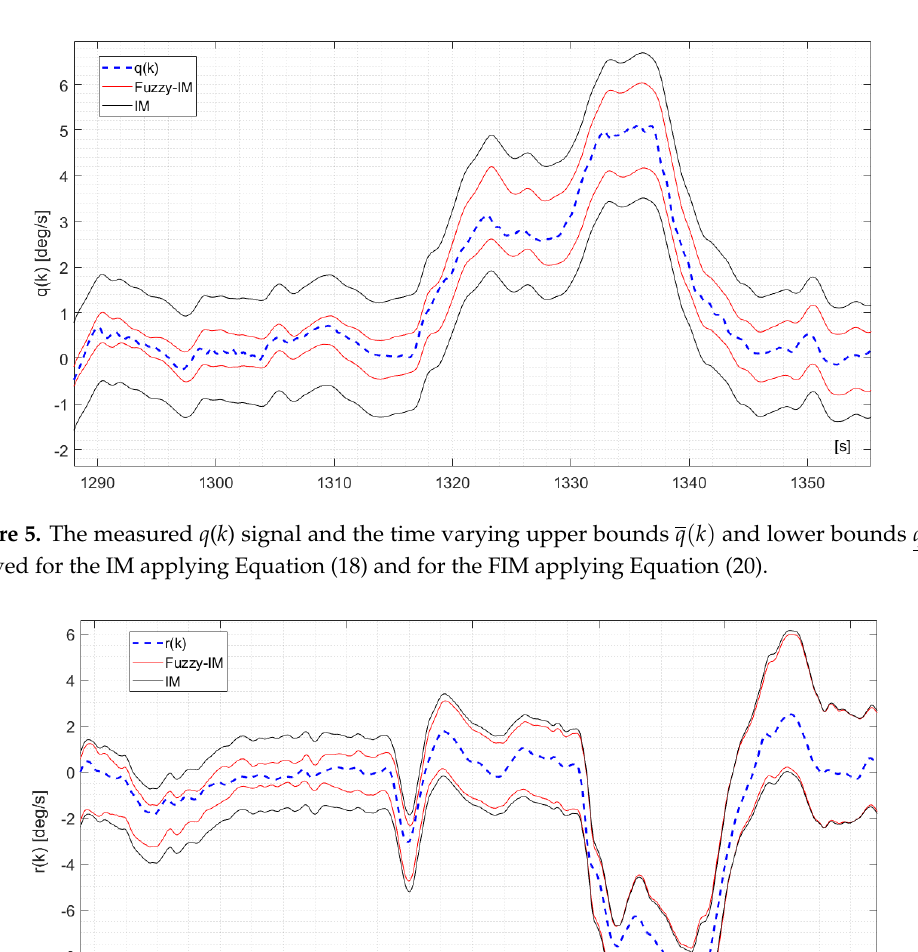
Figure 4. The measured p ( k ) signal and the time varying upper bounds